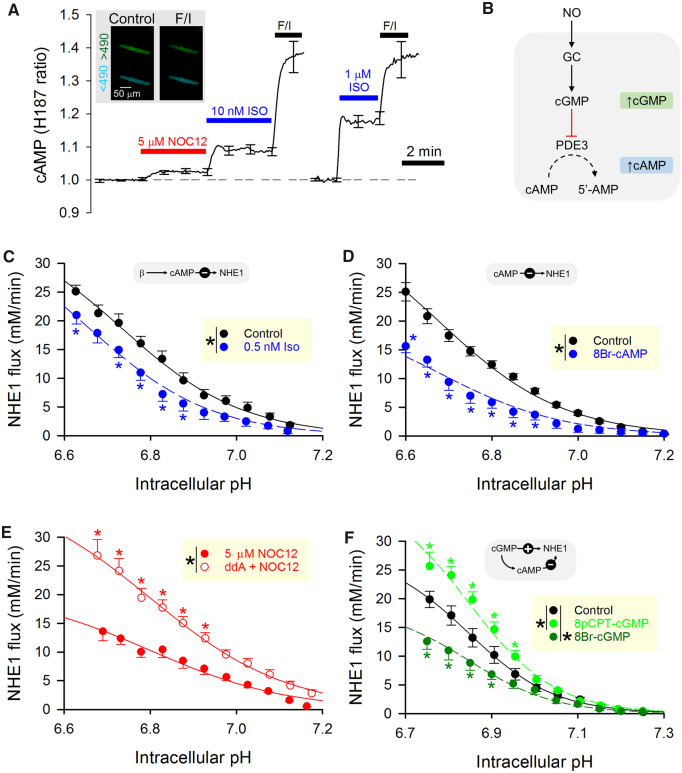
Biphasic regulation of NHE1 by NO is achieved by balancing cGMP-cAMP crosstalk. (A) Rat myocyte infected with H187, a FRET-based sensor of cAMP (inset). NOC12 (5 µM) produced a significant increase in signal. As a positive control, F/I (forskolin and IBMX) raises cAMP to levels that saturate the sensor. Isoprenaline (ISO) is a cAMP-mobilizing β-agonist. NO release from NOC12 produces a rise in [cAMP] equivalent to the effect of ∼1 nM Isoprenaline (Iso). (B) Proposed mechanism through which cGMP increases [cAMP]. (C) Effect of 0.5 nM Iso on NHE1 flux (N = 10 Iso-treated cells from three animals; N = 19 controls from three animals), showing significant reduction in flux (P < 0.0001; two-way ANOVA). (D) Effect of 20 µM 8Br-cAMP on NHE1 flux (N = 15 treated cells from four animals; N = 15 control cells from four animals), showing significant reduction in flux (P < 0.0001; two-way ANOVA). (E) Effect of 5 µM NOC12 when adenylyl cyclase activity is inactivated with membrane-permeable inhibitor dideoxyadenosine (ddA; N = 40 myocytes from five animals). NHE1 flux was significantly greater if cAMP production was ablated (P < 0.0001; two-way ANOVA). (F) Effect of two different membrane-permeable cGMP analogues, 8pCPT-cGMP and 8Br-cGMP, on NHE1 flux vs. control (N = 18, 21, 18 cells from four animals). 8pCPT-cGMP (which does not mobilise cAMP) increased NHE1 activity (P < 0.0001; two-way ANOVA), whereas 8Br-cGMP (which evokes a secondary cAMP signal) decreased NHE1 activity (P < 0.0001; two-way ANOVA).